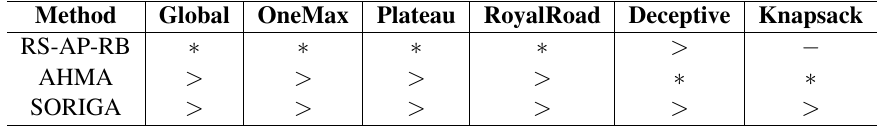
Table 7. Results returned by the Holm’s and Finner’s post-hoc tests at a significance level of α = 0 . 05 when the best learning scheme (RS-AP-RB), SORIGA and AHMA are compared globally and on each specific problem. The symbol ‘*’ indicates the learning scheme considered as control method (the method with the best mean ranking); ‘ > ’ means that the control method improves significantly the corresponding learning scheme; and ‘-’ indicates no significant differences between the two learn- ing schemes. In case both tests do not provide the same result (e.g., Holm’s test does not rejects the hull hypothesis and Finner’s does), Finner’s post-hoc test result is displayed within